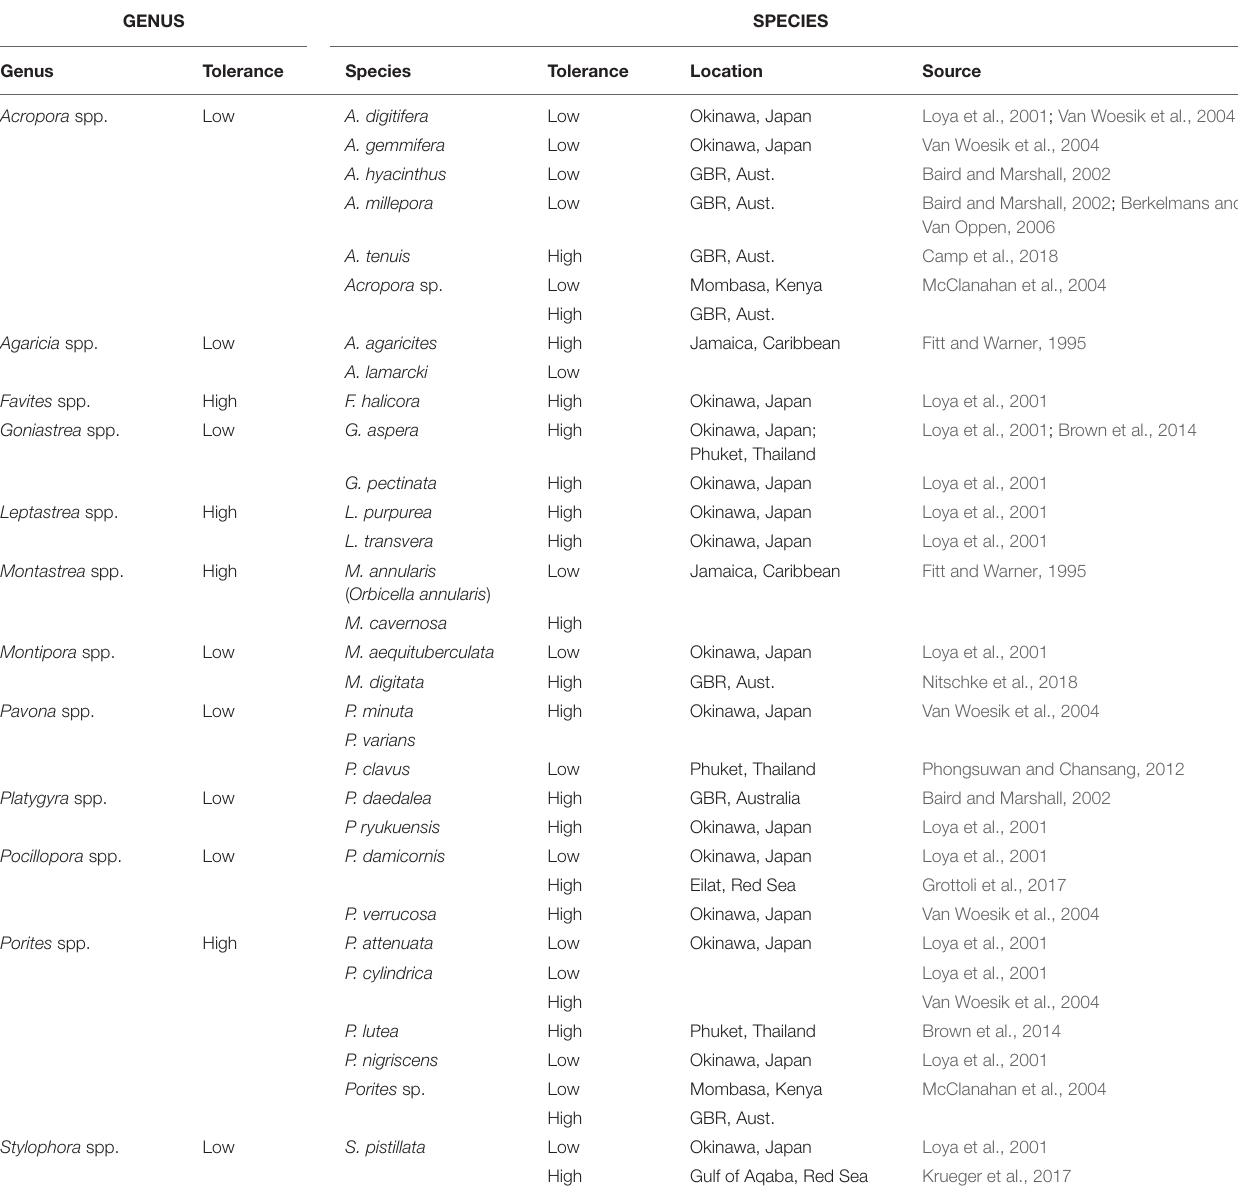
TABLE 2 | Examples of coral genera and species reported to have high or low thermal tolerance. GENUS